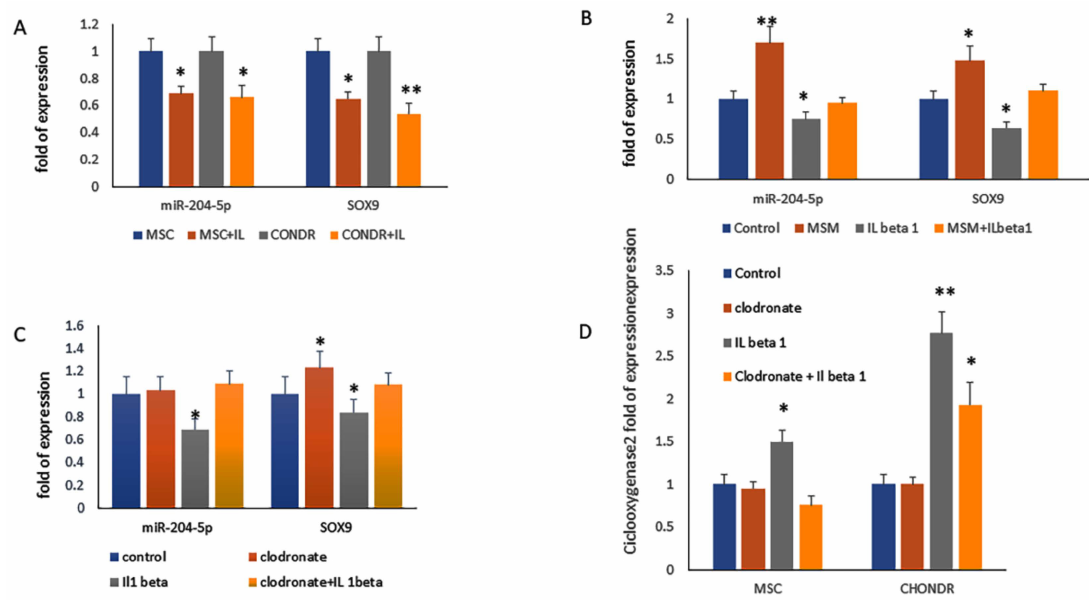
Figure 6. miR-204-5p and SOX9 mRNA expression levels quantified by RT-PCR in ( A ) MSCs during chondrogenesis (7 days post differentiation) and in chondrocytes after interleukin 1 beta (IL 1 beta), ( B ) methylsulphonylmethane (MSM) and ( C ) clodronate treatment. ( D ) Cyclooxygenase 2 mRNA expression levels quantified by RT-PCR in MSCs during chondrogenesis (7 days post differentiation) and in chondrocytes with and without IL 1 beta and clodronate treatment. (* p < 0.05; ** p < 0.005 vs.